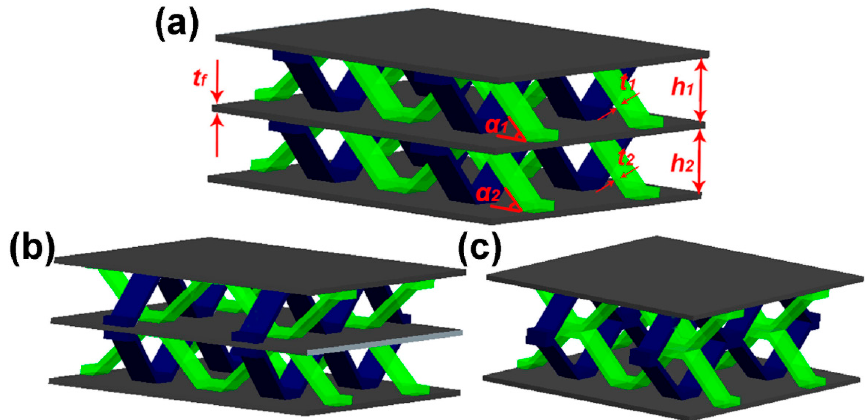
Figure 3. Double-layer structure ( a ) stacked in order (III) ( b ) symmetrically stacked (IV) ( c ) symmetrically stacked but without the intermediate support plate (V).